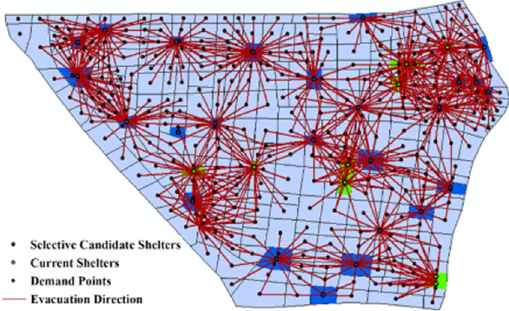
Figure 10. The optimal shelter location scheme.